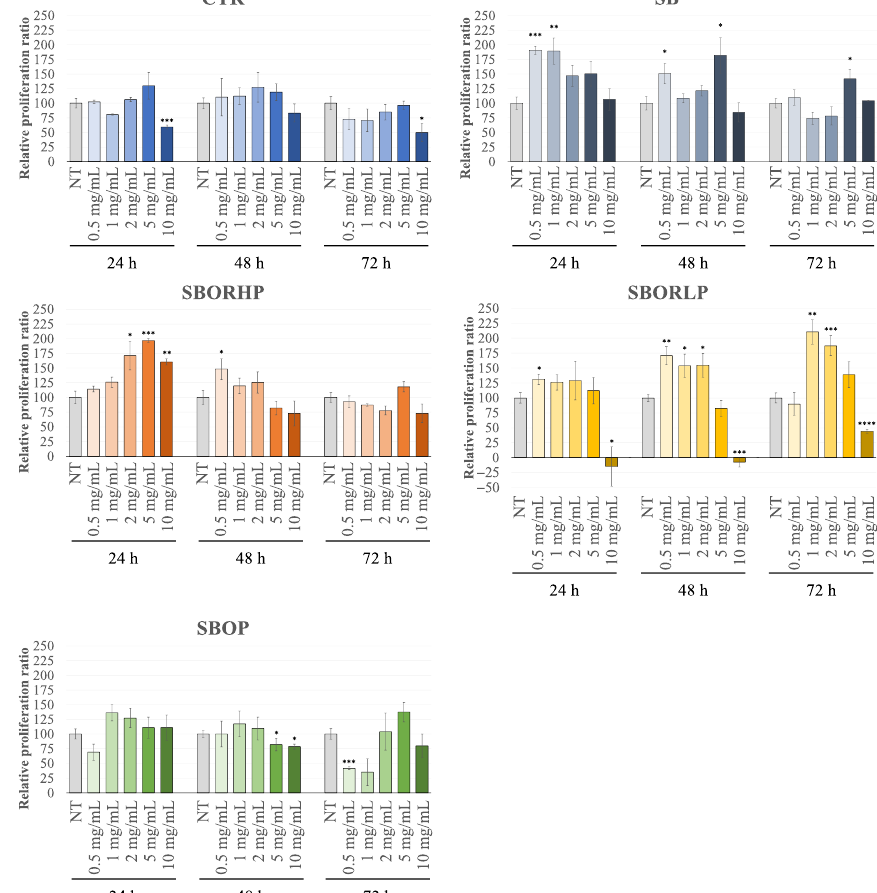
Figure 5. MTT assay performed on the H9c2 cell line. Cells have been treated for 24 h, 48 h and 72 h with different samples of red onions at different concentrations ranging from 0.5 mg/mL to 10 mg/mL. Data were the means ± SEM from at least 3 independent experiments under each condition and were expressed as the percentage of vehicle-treated cells. Statistical analyses were performed using Brown-Forsythe and Welch one-way analysis of variance, and mean comparisons were made using the unpaired t - test with Welch’s correction. * p < 0.05, ** p < 0.01, *** p < 0.001, and **** p < 0.0001.